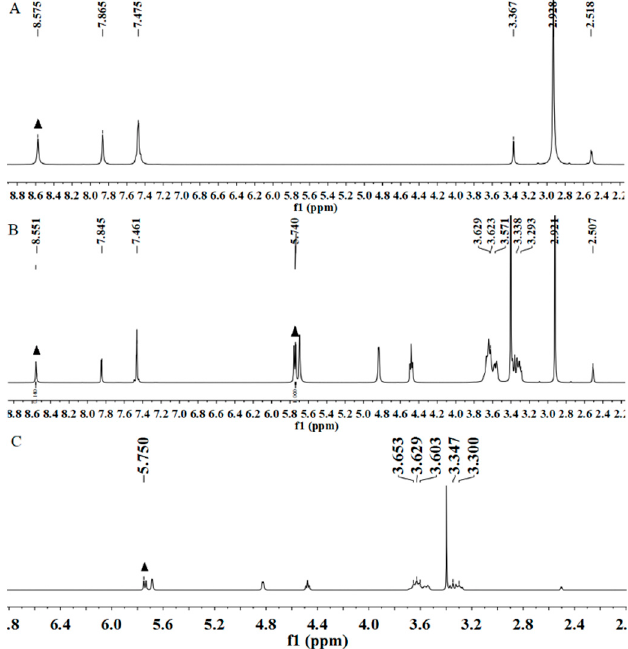
Figure 10. 1 H nuclear magnetic resonance (NMR) spectra: ( A ) diuron; ( B ) the inclusion complex; and ( C ) β -CD. Table 1. Chemical shift of inclusion complexes relative to diuron and cyclodextrin.